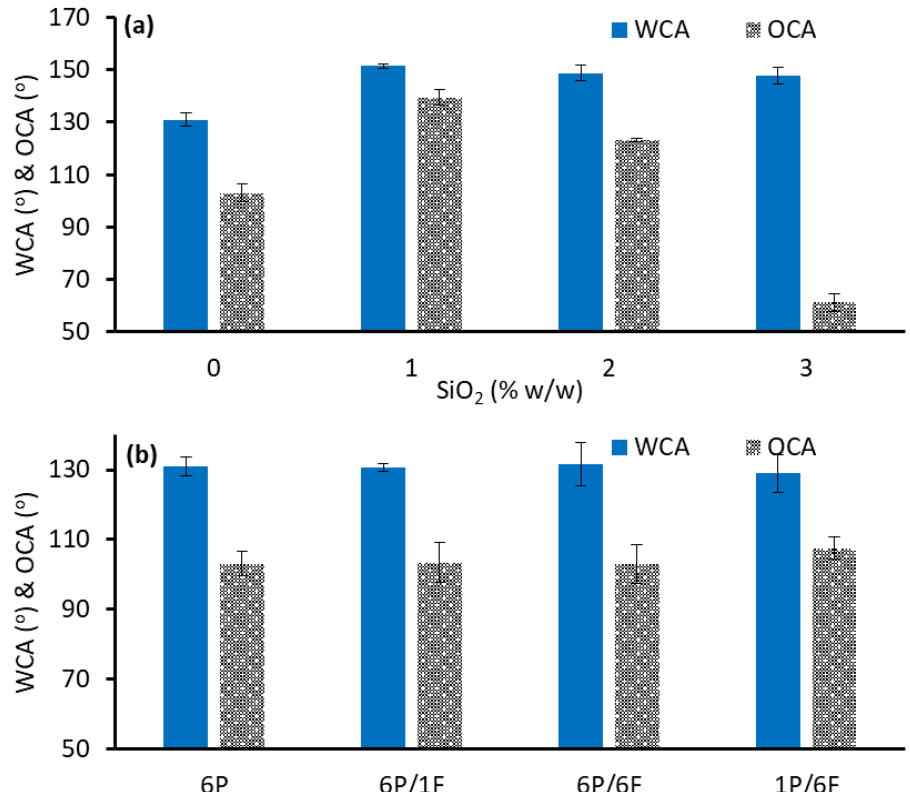
Figure 2. ( a ) WCA and OCA vs. SiO 2 NP concentration for the 6P-based coatings (F was not used). ( b ) WCA and OCA on surfaces of which were prepared by blending P and F in different ratios (NPs were not used).